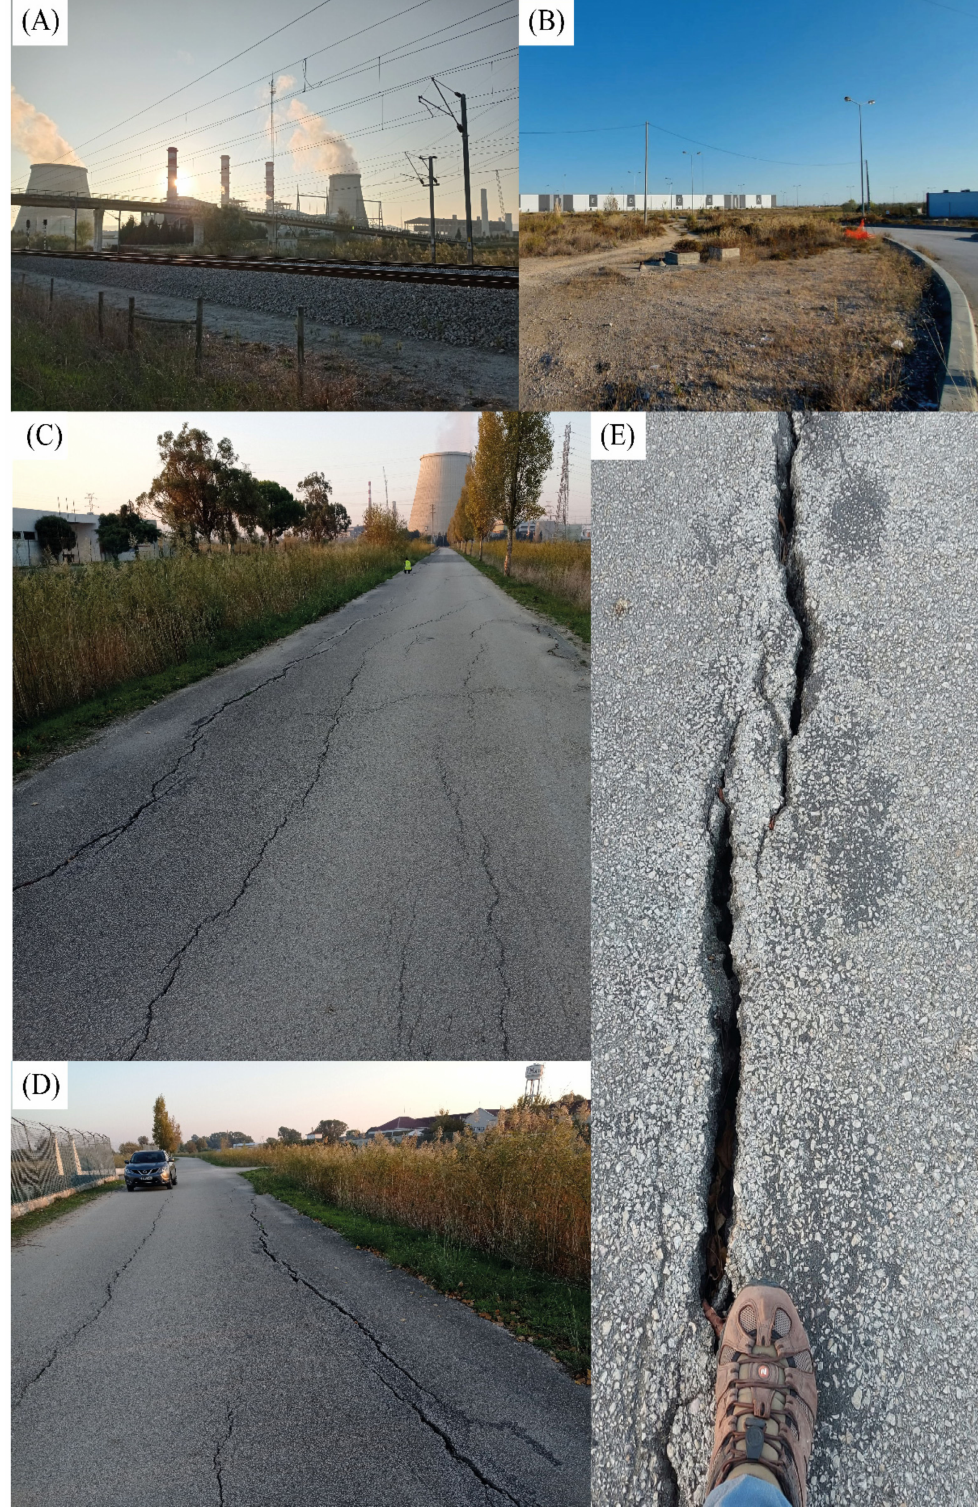
Figure 6. Photos of evidence observed in field campaigns in October and November 2021. ( A ) Car- regado thermoelectric plant; ( B ) industrial polygon of Vila Franca de Xira; ( C ) and ( D ) tension cracks affecting a road in Vila Franca de Xira surroundings and near to Carregado thermoelectric plant; ( E ) opened tense cracks with centimetric opening. See locations in Figures 5 and